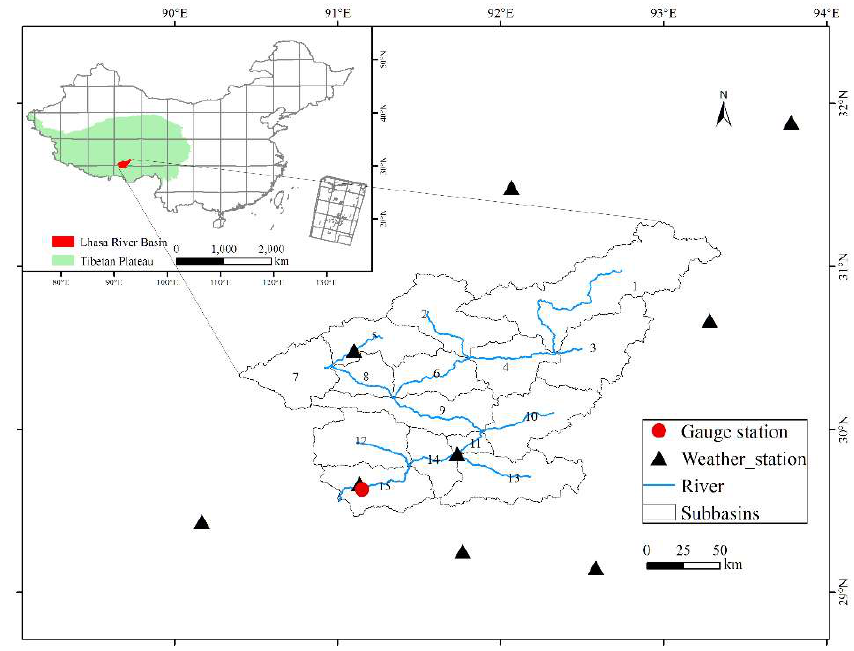
Figure 4. Lhasa River watershed with the geographical locations of the hydrological and meteorological stations in the study area.